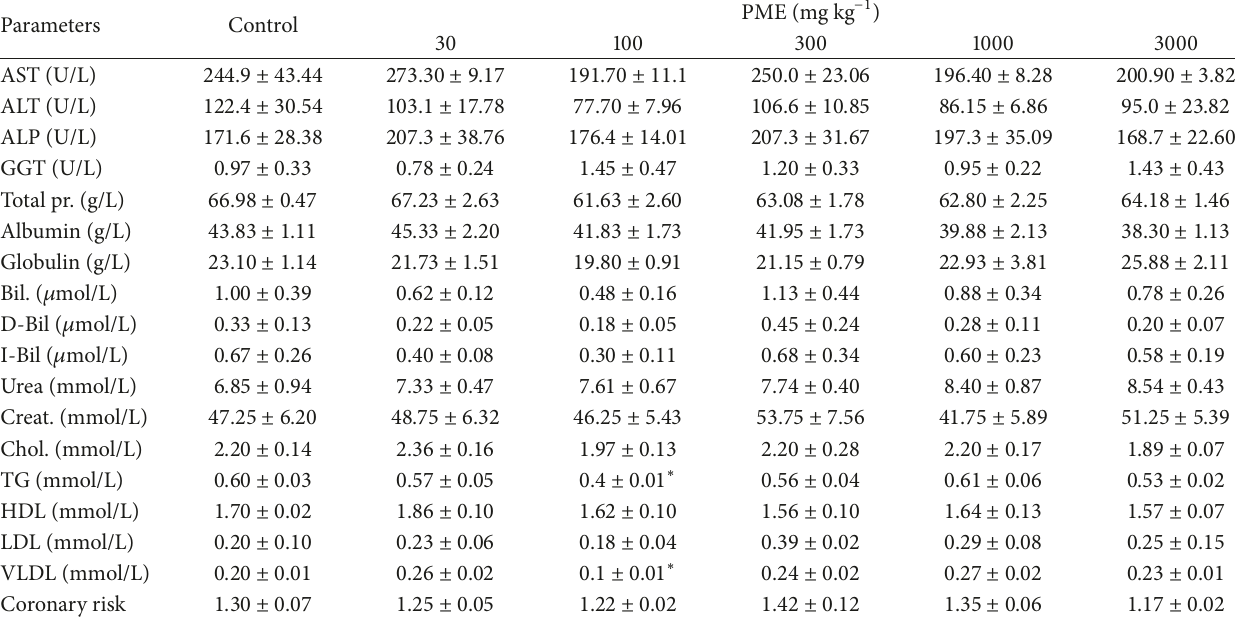
Table 4: Effect of 14-day treatment with PME on biochemical parameters in